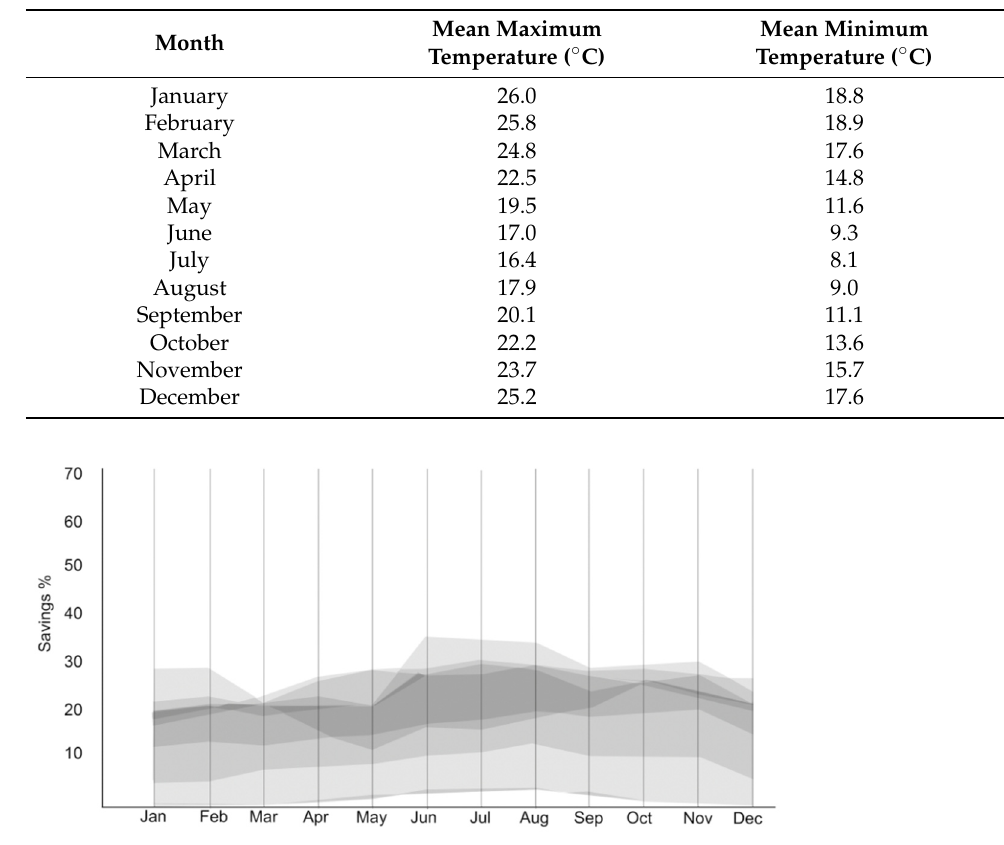
Table 4. Monthly mean maximum and mean temperature in Sydney [48].